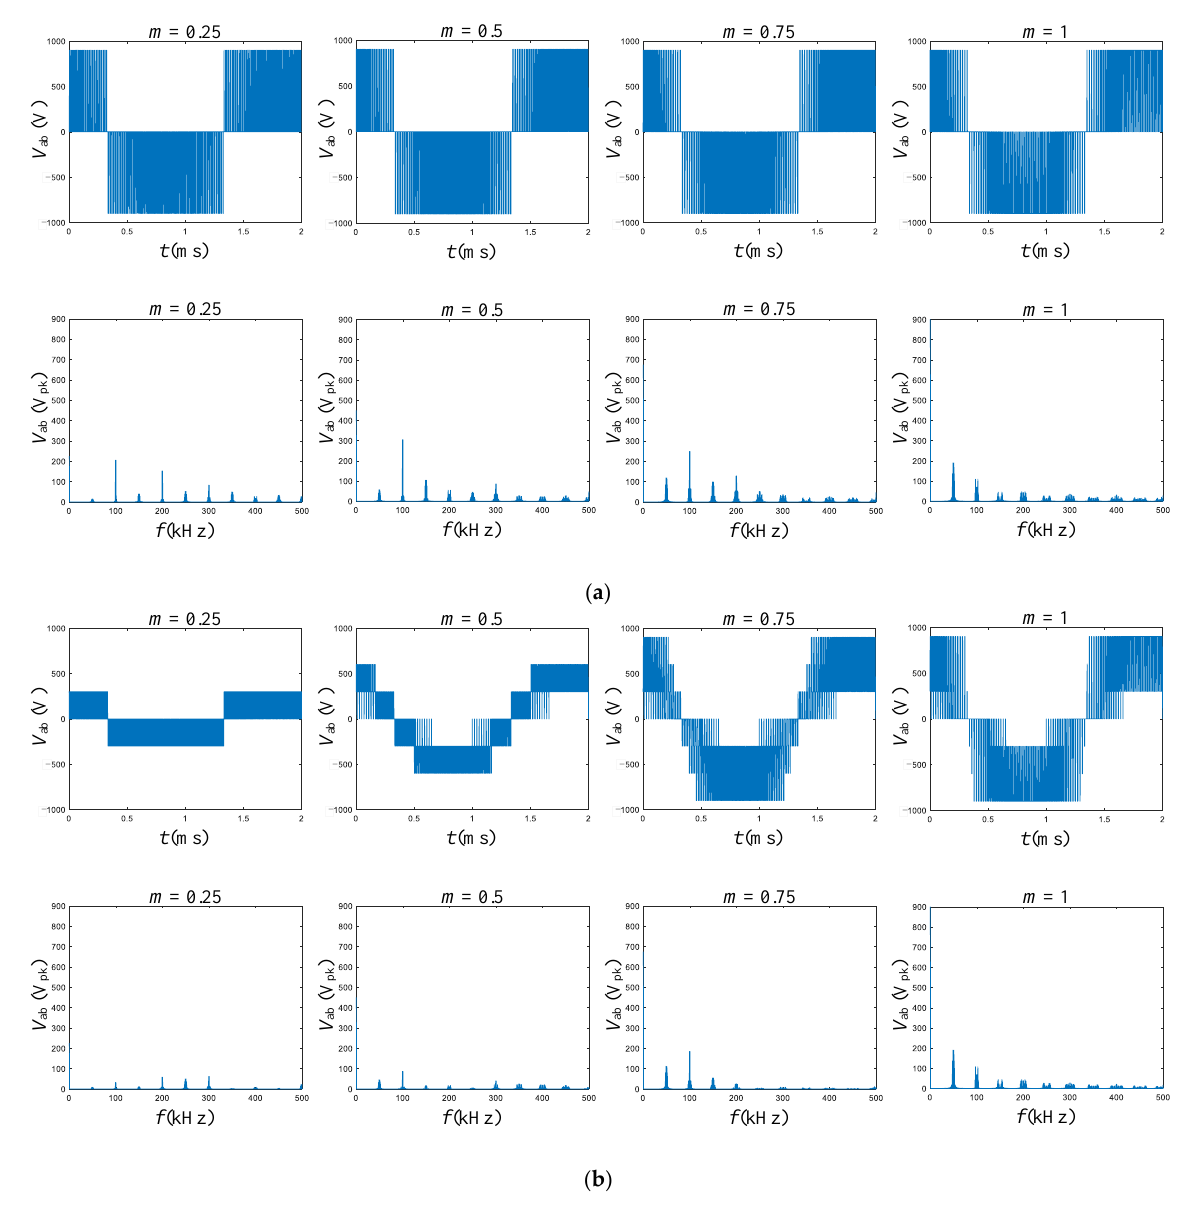
Figure 8. Time-domain and frequency-domain plots of the motor line-to-line voltage in EV 3 under four different modulation index values. ( a ) Design A. ( b ) Design B.